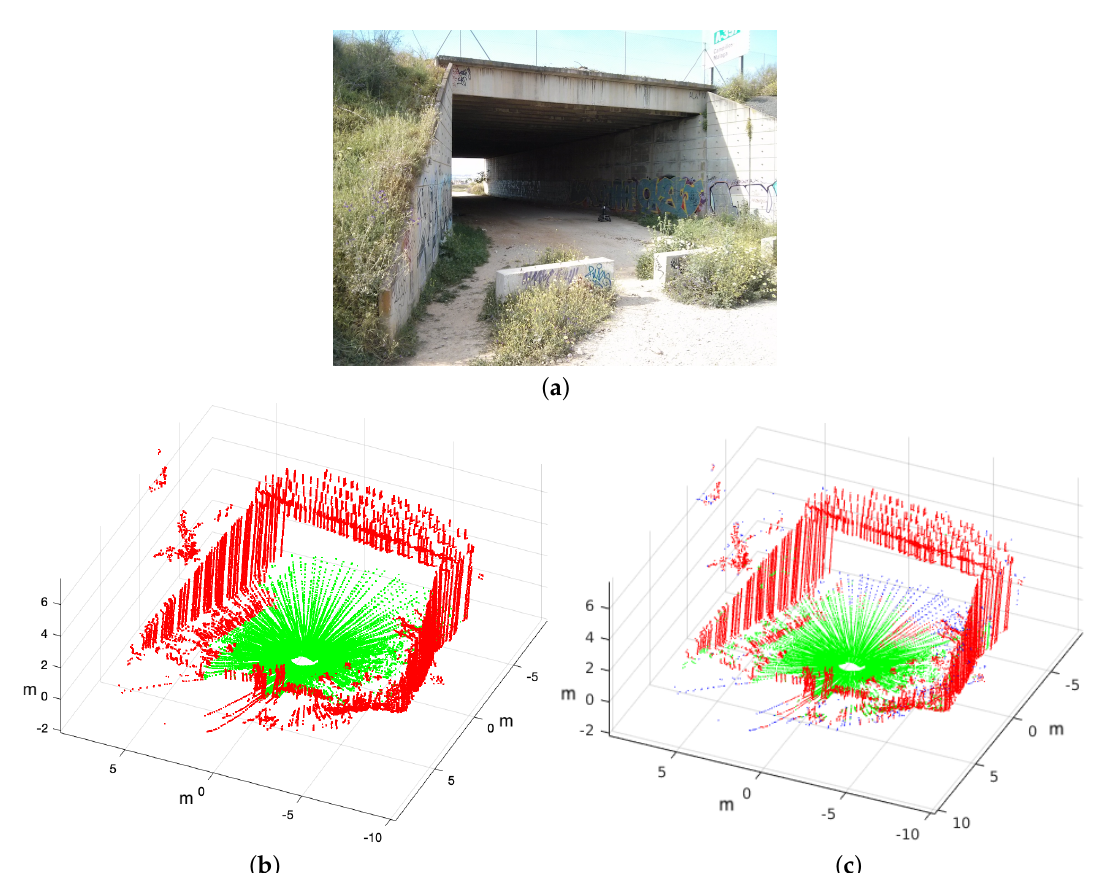
Figure 11. A photograph of an underpass ( a ) and a real 3D point cloud from Andabata manually-tagged ( b ) and classified with RF ( c